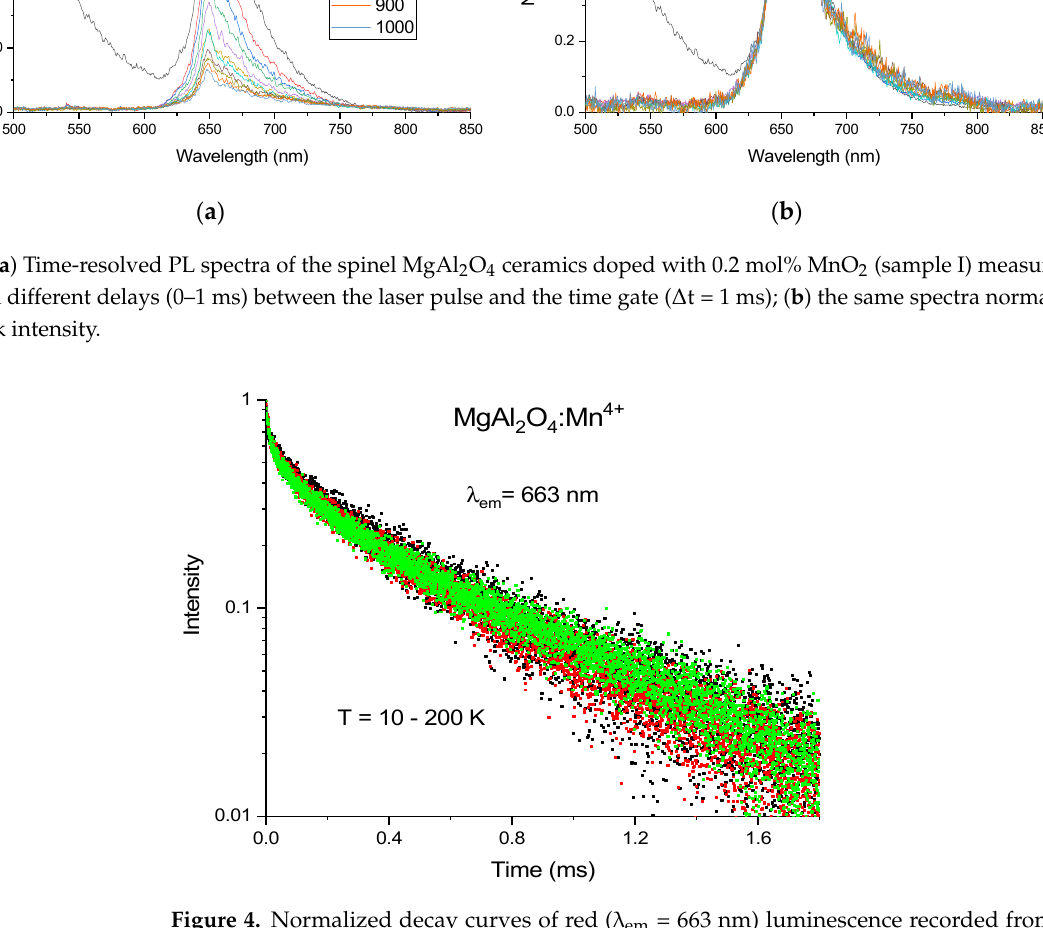
Figure 3. ( a ) Time-resolved PL spectra of the spinel MgAl 2 O 4 ceramics doped with 0.2 mol% MnO 2 (sample I) measured at 290 K with different delays (0—1 ms) between the laser pulse and the time gate ( Δ t = 1 ms); ( b ) the same spectra nor- malized to the peak intensity.